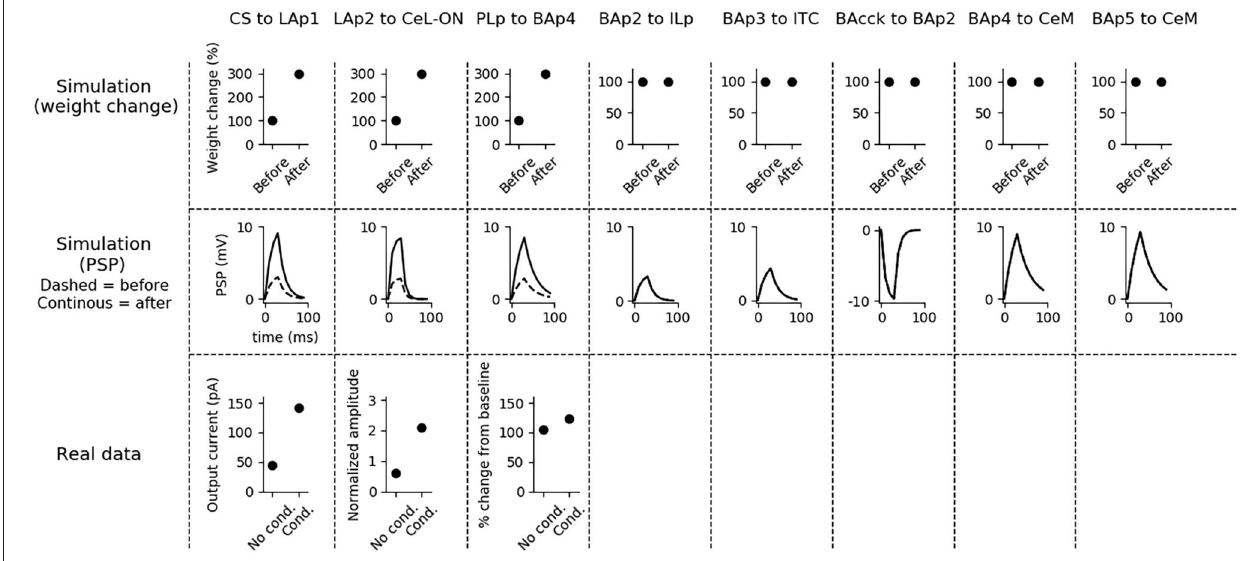
FIGURE 4 | Changes of the connection weights and PSP before and after fear conditioning. First row: simulated connection weights before and after fear conditioning. Second row: simulated effect of a 30 ms presynaptic stimulation on the PSP of the plastic connections of the model (the presynaptic stimulation was adjusted to obtain a change of maximum 10 mV in the postsynaptic unit). Third row: available real data from literature, showing an LTP respectively in the output current evoked in LA neurons by a stimulation of the CS-pathway ( McKernan and Shinnick-Gallagher, 1997), in the normalized current evoked in CeL-ON neurons with a stimulation of LA (Li et al., 2013), and in the response of BA to the mPFC input (Vouimba and Maroun, 2011). The other simulated synapses shown here to be stable have never been reported in the literature to undergo LTP or LTD during fear conditioning.